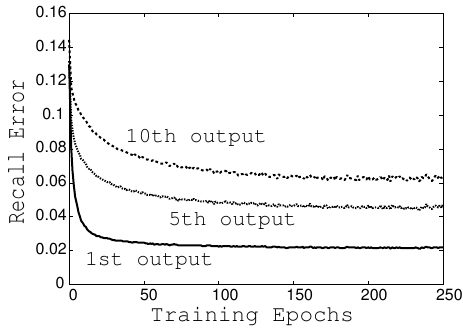
Figure 5: Recall errors during training of visual LSTM